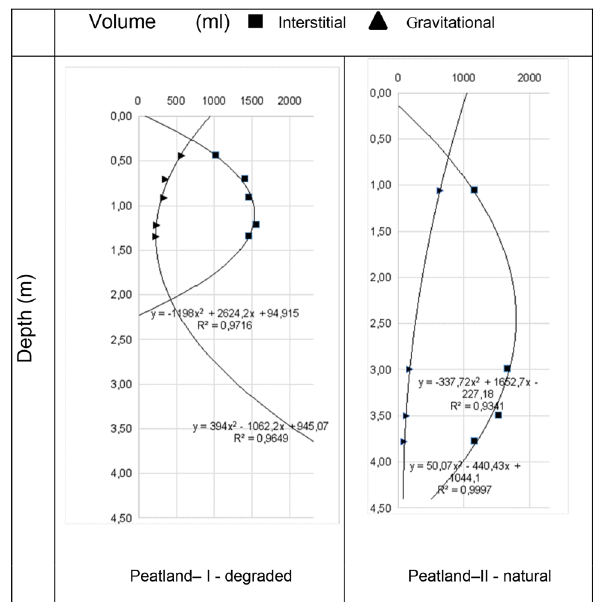
Fig. 6 Trends of gravitational and interstitial water retention at the midpoint of each layer, considering the maximum depth of each kind of Sphagnum peatland (I-degraded, II-natural). Interstitial water is associated with retention capacity; gravitational water is associated with efflux delay